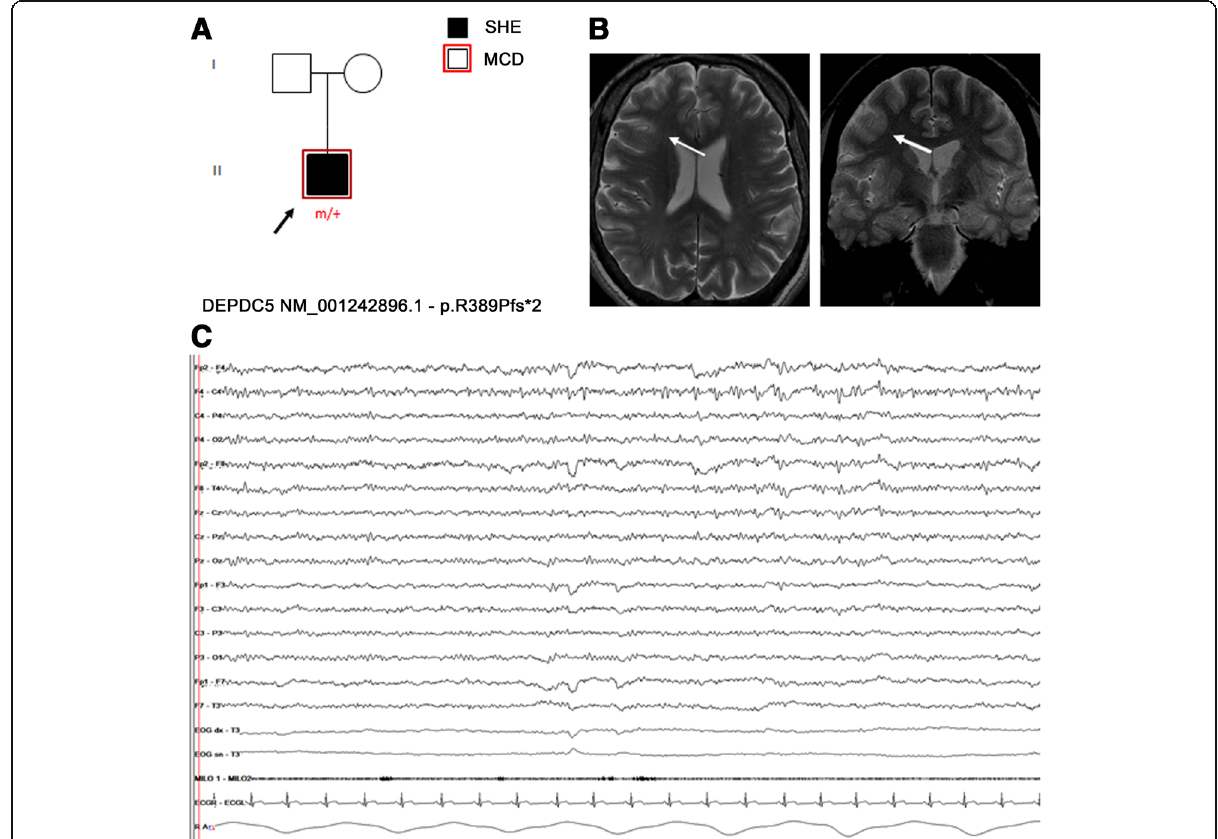
Fig. 2 a Pedigree of an isolated SHE patient carring the frameshift DEPDC5 mutation p.R389Pfs*2. Previously published in Baldassari et al., 2019 (Proband 18). b Targeted brain MRI showed a focal increase of cortical thickness with blurring of gray-white matter junction, over the right medium frontal gyrus (white arrows), suggestive of focal cortical dysplasia. c Interictal EEG showing repetitive low-amplitude sharp-waves over the right fronto-central region, enhanced by